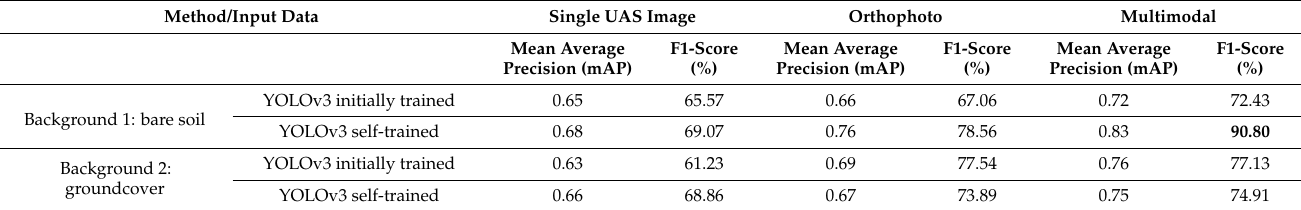
Table 5. Overall external test evaluation metrics (best result in bold) on all available datasets for two validation sets (1740 samples in